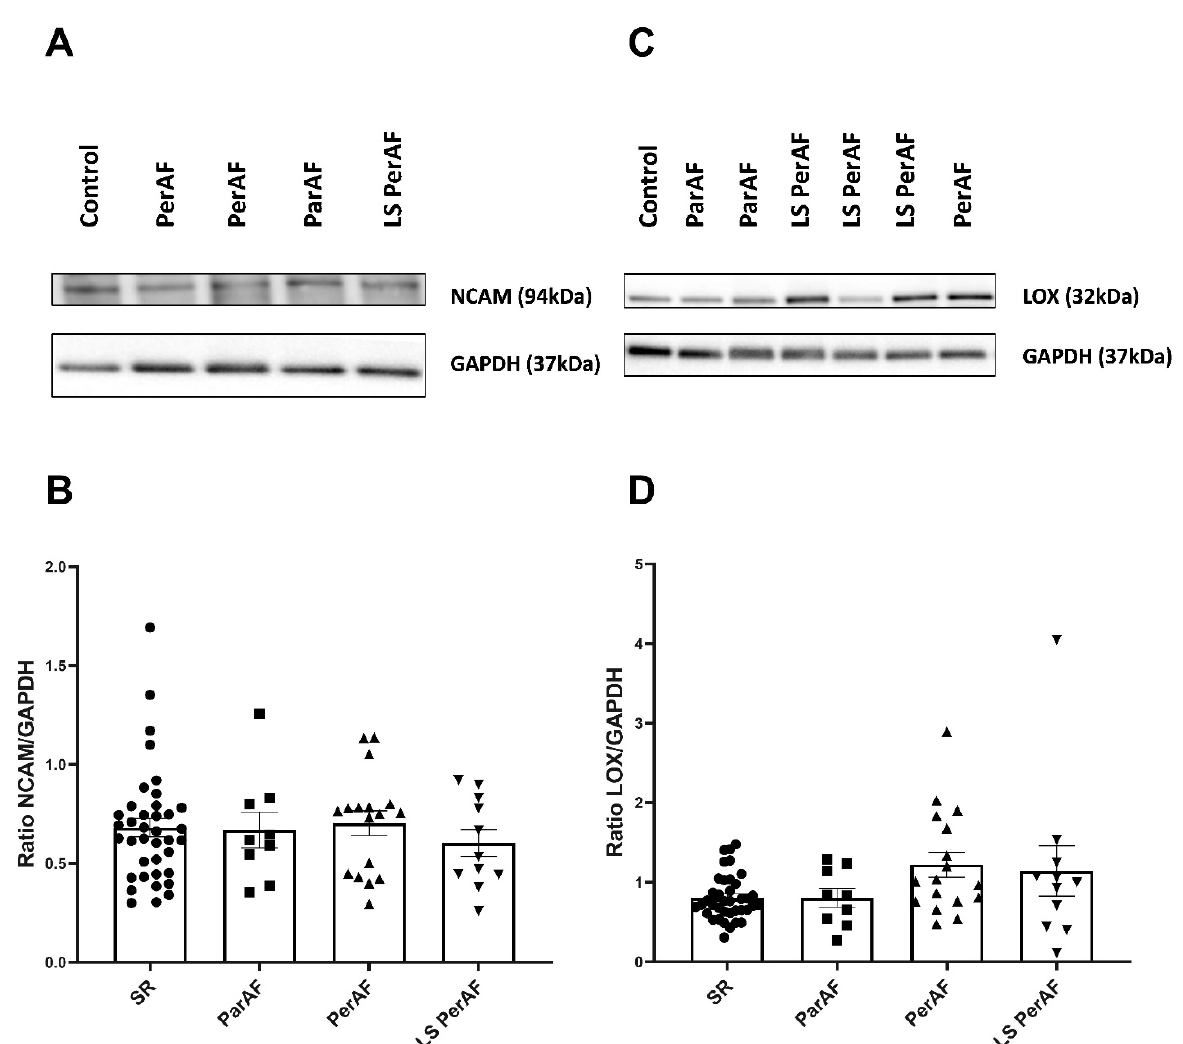
Figure 4. Fibroblast marker (NCAM and collagen crosslinking promoter (LOX). No significant difference was observed between various stages of AF and control SR group, in terms of NCAM (N = 76) ( B ) and LOX (N = 92) ( D ), respectively, p = 0.83 and p = 0.11. Representative blot images for NCAM and LOX expression are illustrated in ( A , C ), respectively. SR = control group, ParAF = paroxysmal atrial fibrillation, PerAF = persistent atrial fibrillation, LSPerAF = longstanding persistent atrial fibrillation. Statistical tests used: ANOVA.